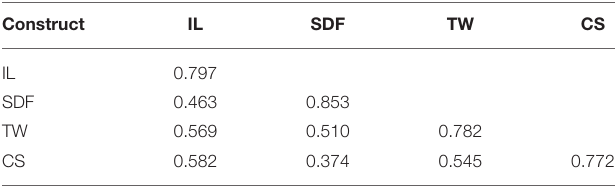
TABLE 2 | Discriminant validity analysis (Fornell and Larcker). Construct